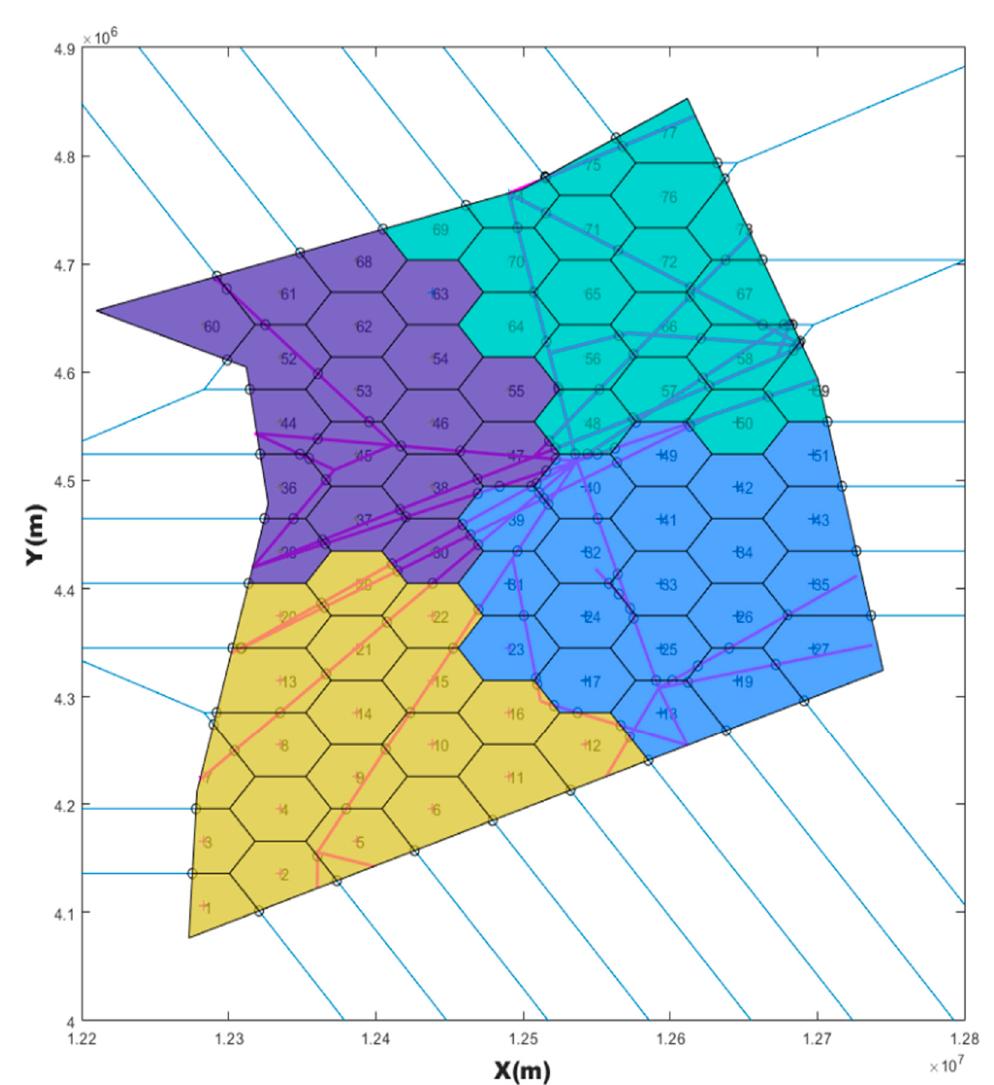
Figure 7. Intersection of all routes with the Voronoi cell (VC) they pass through.